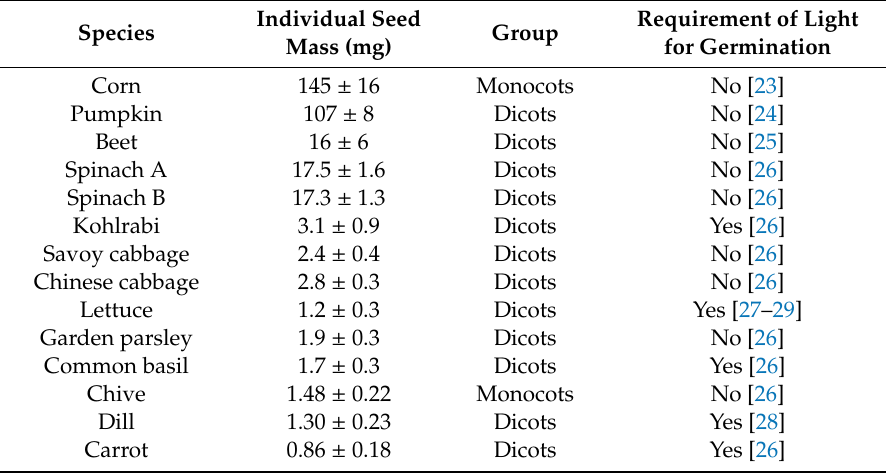
Table 2. Characterization of the seeds used in this study, sorted by the seed mass (N = 100).